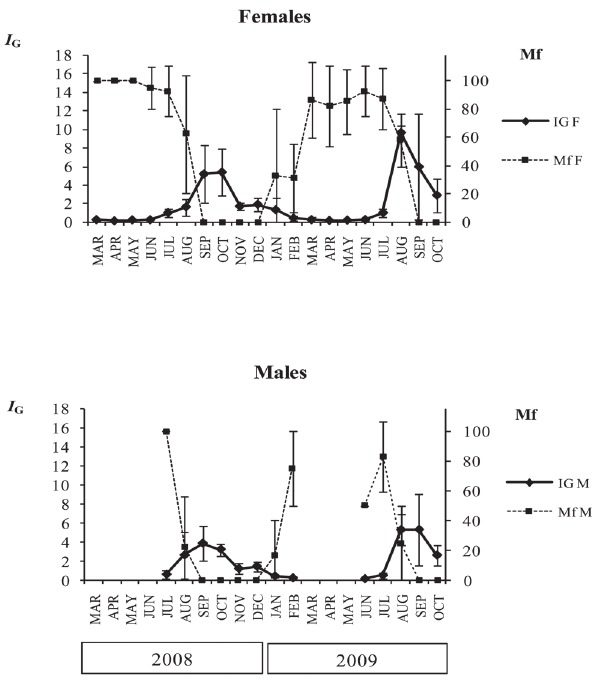
, gonadosomatic index. Fig.7. Monthly variation analysis of the gonasosomatic index G ( I ) of Females ( I F; n=200) Males ( I M; n=57); and fat G G G deposited in the mesenteries (Mesenteric fat – Mf F; Mf M) of Alphestes afer from Pernambuco coast. Error bars show standard deviation of original